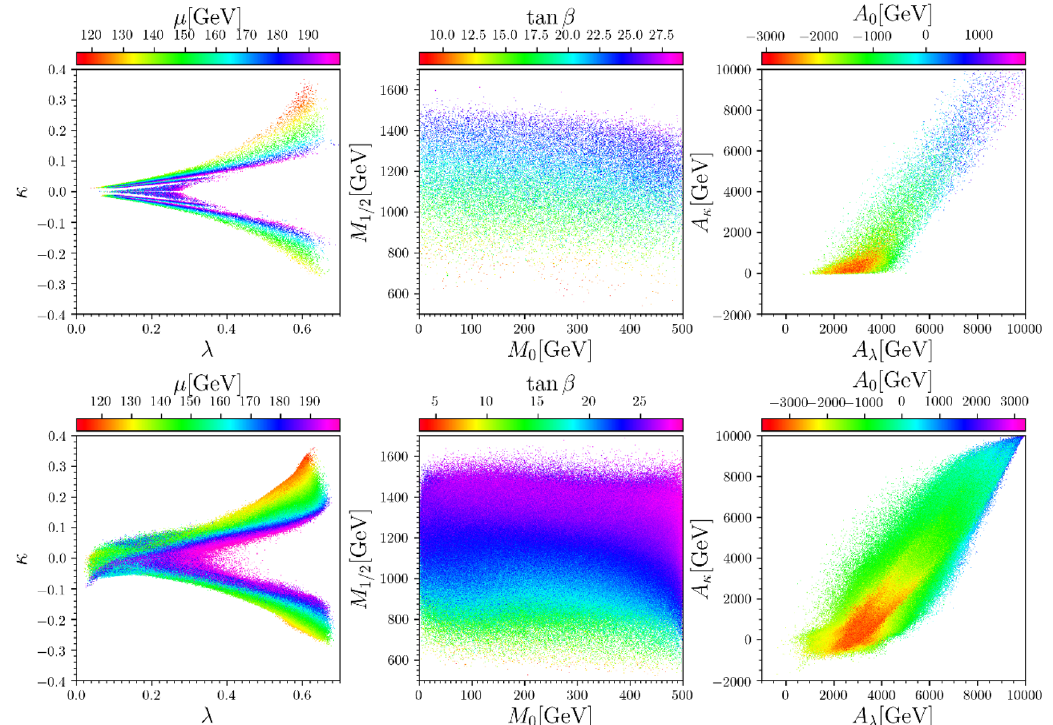
Figure 2 . The samples’ distributions in the (cid:20) versus (cid:21) (left), M A (cid:21) (right) planes. From left to the right, colors indicate the (cid:22) , tan (cid:12) and A 0 , respectively. Upper panel: the training set for GAN, which are the original perfect samples generated in our (cid:12)rst search. Lower panel: the recommended samples from GAN, which are generated by the Generator G in our well-trained